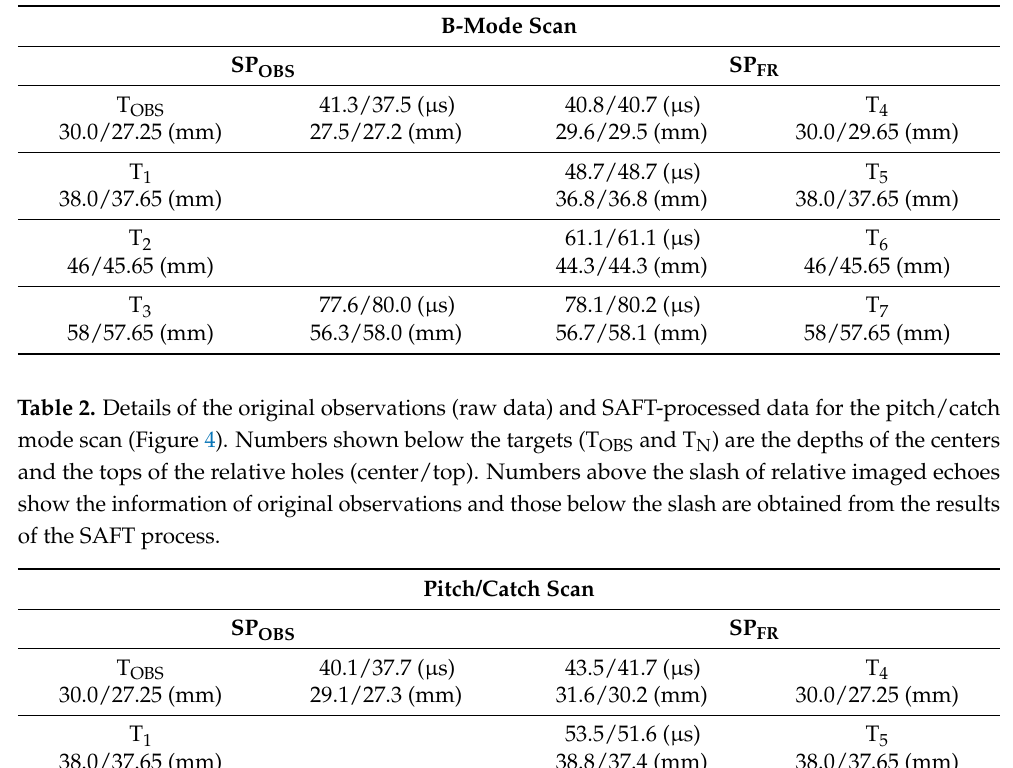
Table 1. Details of the original observations (raw data) and SAFT-processed data for the B-mode scan (Figure 3). Numbers shown below the targets (T OBS and T N ) are the depths of the centers and the tops of the relative holes (center/top). Numbers above the slash of relative imaged echoes show the information of original observations and those below the slash are obtained from the results of the SAFT process.